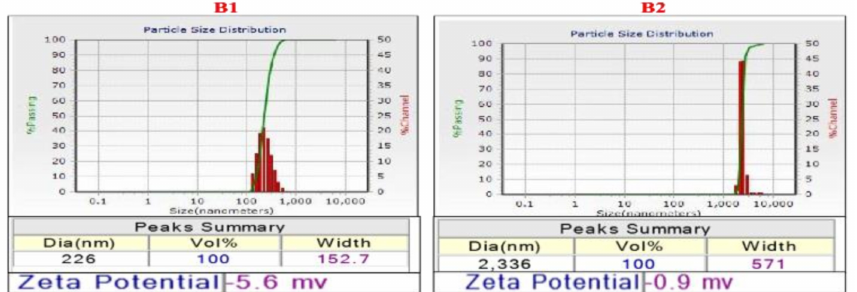
Figure 6. DLS size distribution graph of nanoconjugates formed from ( B1 ) aqueous extract and ( B2 ) methanolic extract.